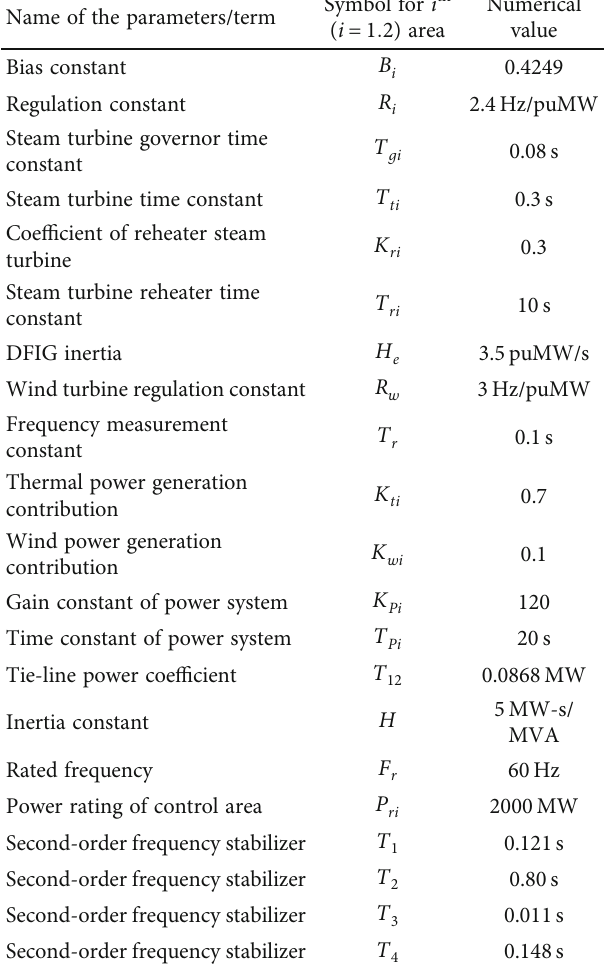
Table 5: List of symbols and numerical data. Name of the parameters/term